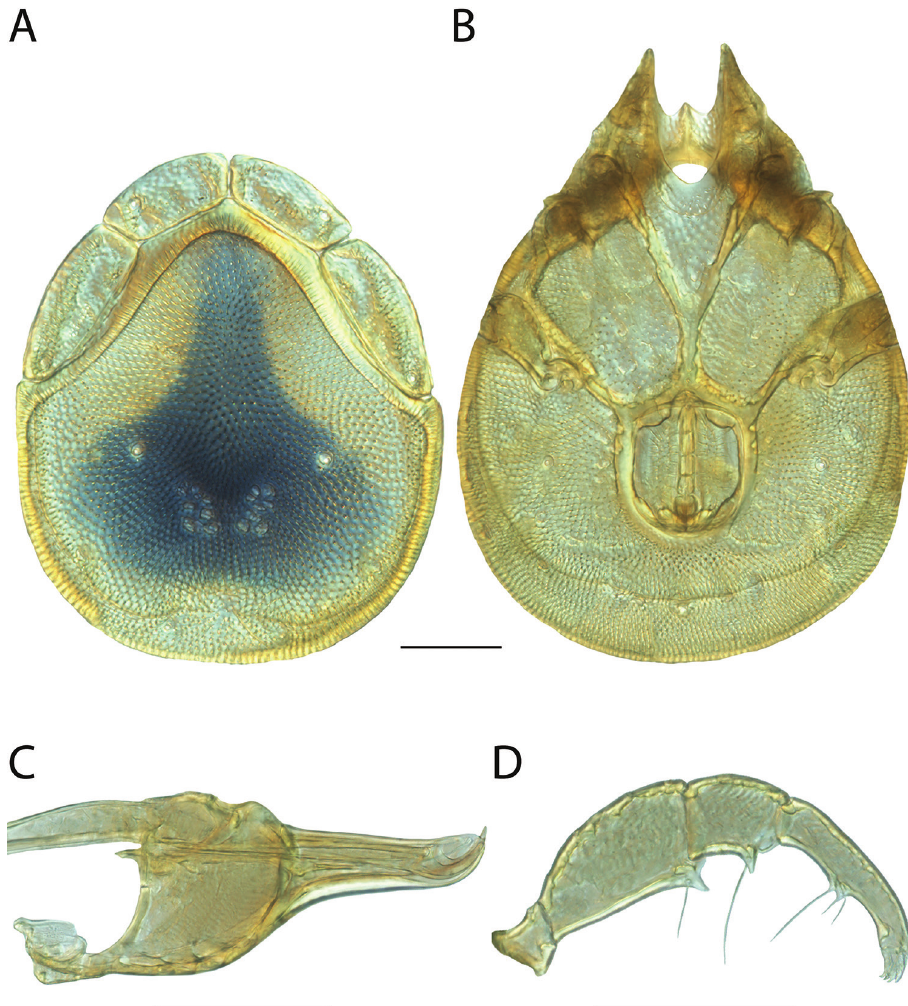
Figure 89. Torrenticola gnoma sp. n. male: A dorsal plates B venter (legs removed) C subcapitulum D pedipalp (setae not accurately depicted). Scale = 100